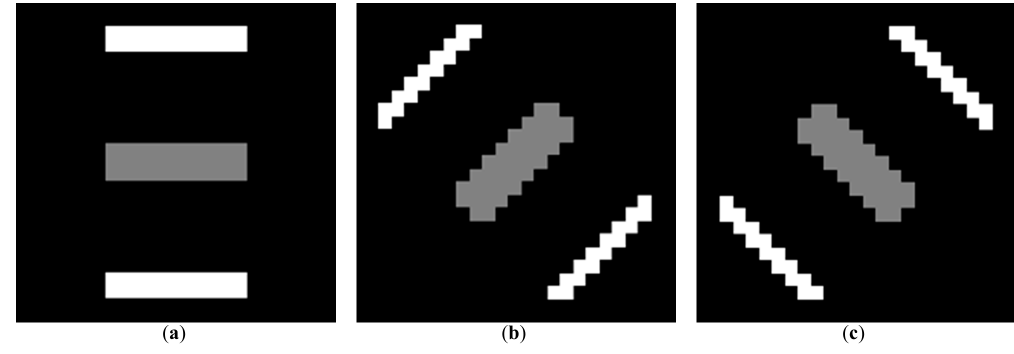
Figure 7. Three sample rotated templates: ( a ) Rotated by − 90°; ( b ) Rotated by − 45°; ( c ) Rotated by +45°.